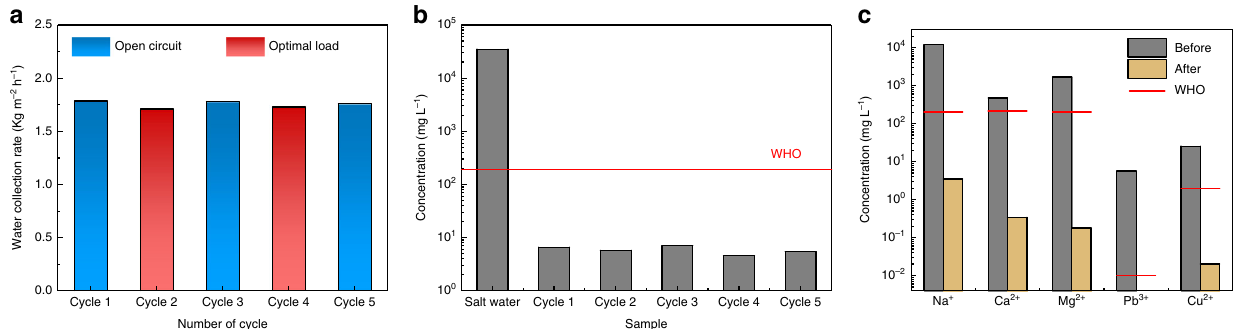
Fig. 5 Reusability evaluation of the photovoltaics-membrane distillation (PV-MD) device. a Water production rate in different cycles under open circuit state (blue column) and optimal stage (red column) via the 3-stage photovoltaics-membrane distillation (PV-MD) device with dead-end mode for salt water desalination, b water salinity of the source water and desalinated water collected in every cycle (The red line is the World Health Organization ’ s (WHO) guidelines for drinking-water quality). c Ion concentrations of the heavy-metal contaminated source water and desalinated water by PV-MD